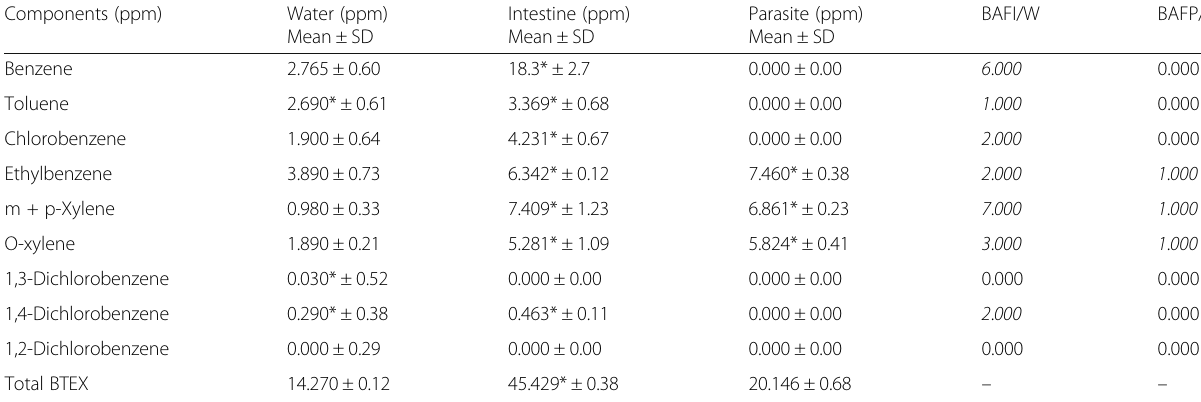
Table 3 Bio-concentration factor of BTEX in water-fish ( Synodontis clarias )-parasite ( Procamallanus laevionchus ) transit Components (ppm)